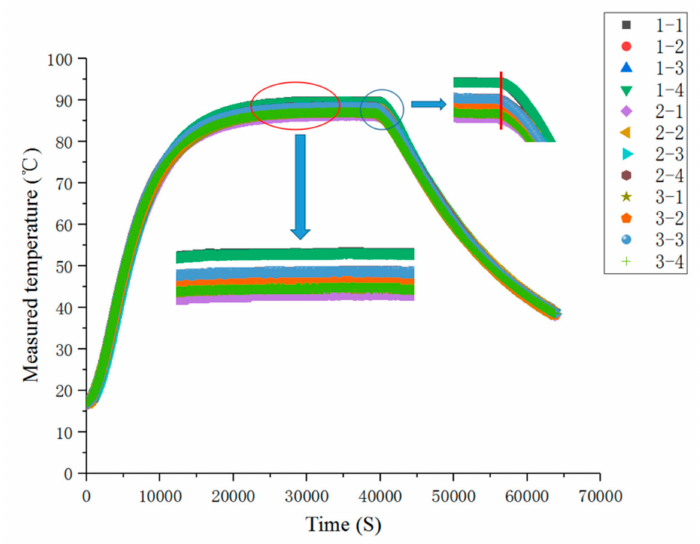
Figure 12. Transient measurement results of the temperature at each measuring